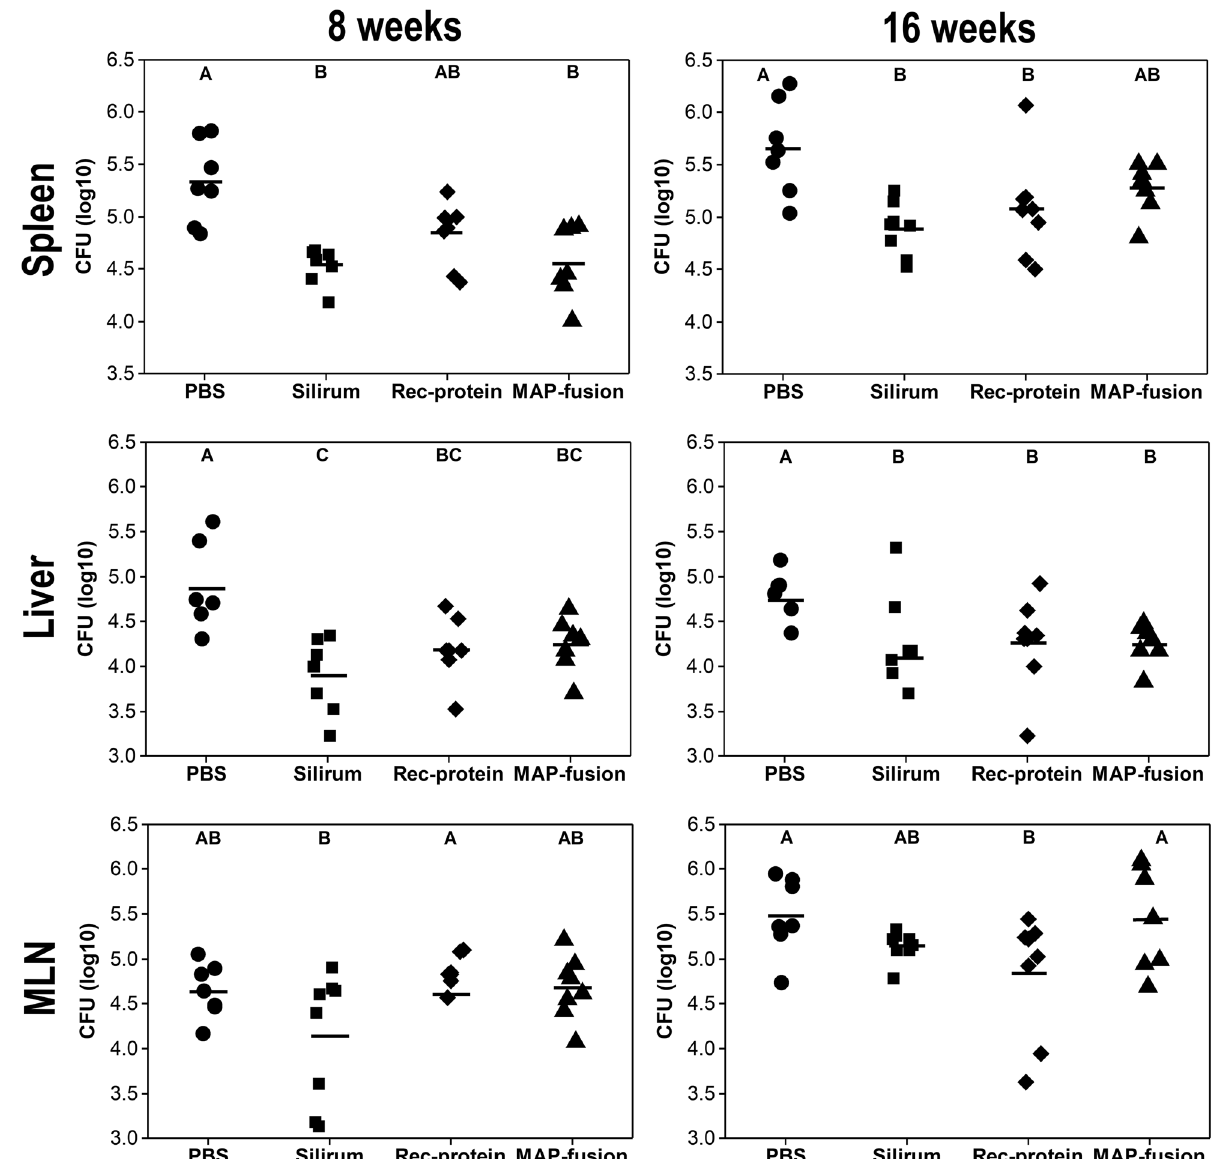
Figure 5. MAP burden following challenge. MAP burden [colony forming unit (CFU log 10 )] was enumerated in spleen, liver, and MLN at 8 weeks and 16 weeks post-challenge. Mean CFU (log 10 ) is represented by horizontal lines for each group. MAP burden between the vaccine groups is significantly different where they do not share a letter (A, B, and C) with significance cut-off of P < 0.05 after using the BH p-value